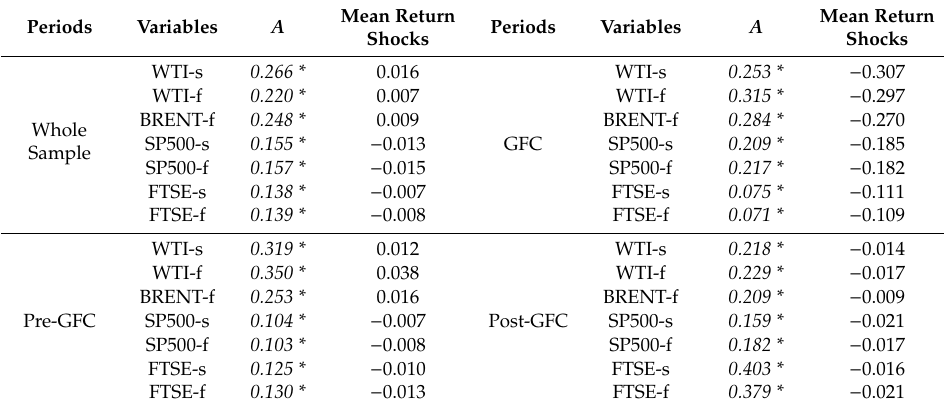
Table 9. Matrix A in Diagonal BEKK and mean return shocks for the UK and US spot and futures markets, four periods (7 ×